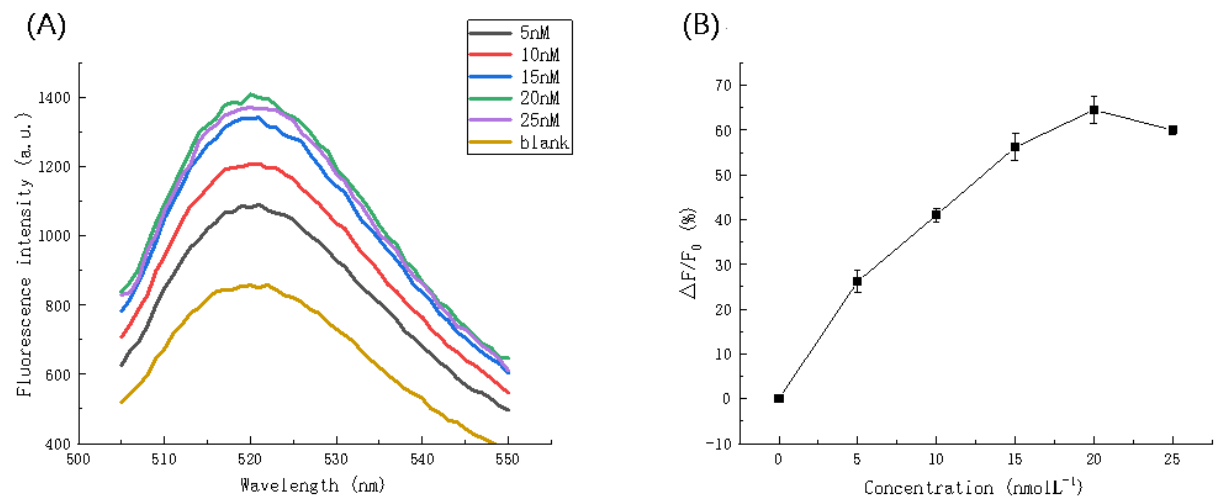
Figure 3. ( A ) Fluorescence spectra and ( B ) Fluorescence intensity ratio ( △ F / F 0 ) at different concentrations of padlock probe.